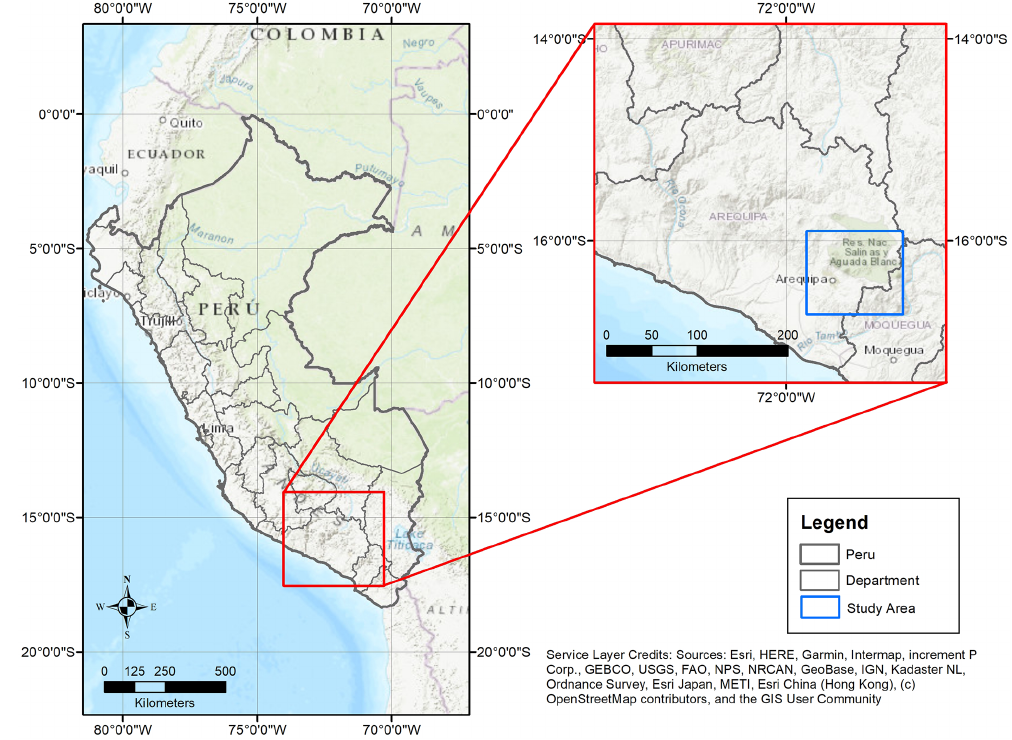
Figure 1. Map of the Arequipa department in southern Peru, the Quilca–Vitor–Chili River basin, and our study area in the northeastern part of this